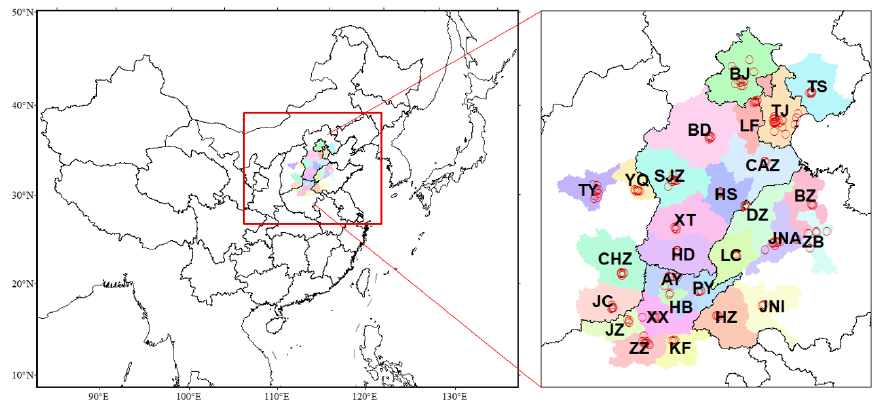
Figure 1. Simulation domain and observation sites in 2 + 26 cities of North China Plain (red dots: surface monitor sites for NO 2 , SO 2 , O 3, and PM 2.5 ; the 28 cities are BJ, Beijing; TJ, Tianjin; BD, Baoding; CAZ, Cangzhou; HD, Handan; HS, Hengshui; LF, Langfang; SJZ, Shijiazhuang; TS, Tangshan; XT, Xingtai; TY, Taiyuan; YQ, Yangquan; ZZ, Zhengzhou; JZ, Jiaozuo; AY, Anyang; HB, Hebi; XX, Xinxiang; KF, Kaifeng; PY, Puyang; HZ, Heze; LC, Liaocheng; DZ, Dezhou; JNI, Jining; ZB, Zibo; JNA, Jinan; BZ, Binzhou; JC, Jincheng; CHZ, Changzhi).